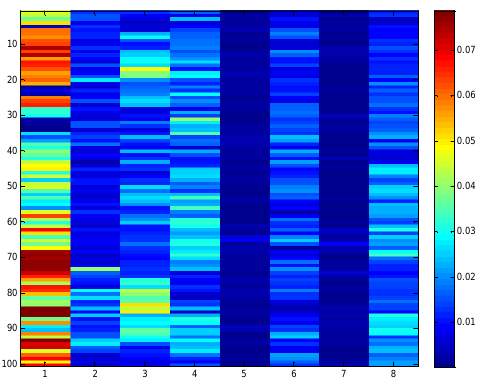
Figure 5. Variance of HOG histograms using 9 windows for each sample (1: agricultural, 2: airplane, 3: beach, 4: buildings, 5: chaparral, 6: dense residential, 7: forest, 8: harbor).